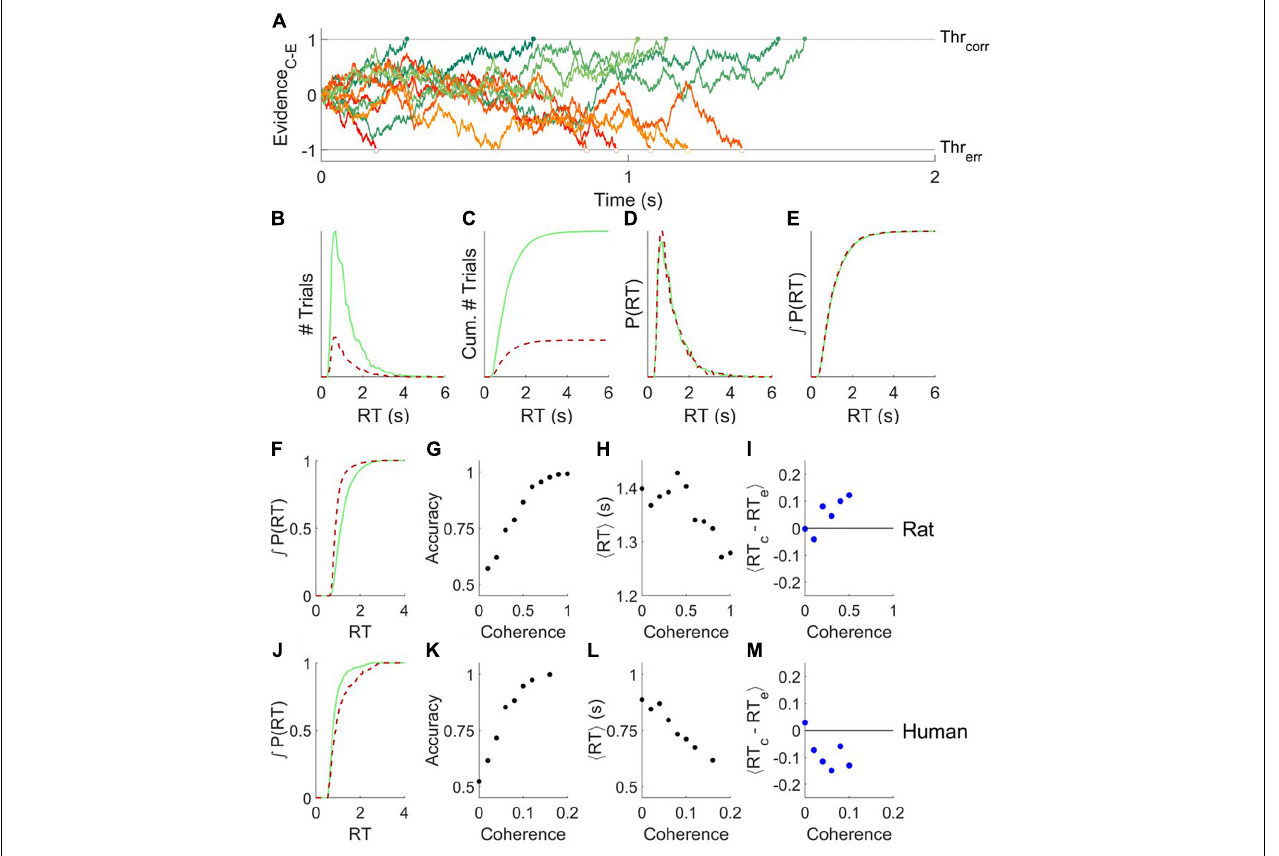
FIGURE 1 | The basic drift diffusion model is incompatible with data from rats or humans. (A) Simulated evidence accumulation in a basic drift diffusion model, for six example trials that terminated in correct decisions (green shades, solid symbols) and six that terminated in error decisions (red shades, open symbols). Although an equal number of traces are shown, in the condition illustrated 80% of the traces terminated by crossing the correct boundary. (B) Response time distributions for errors (red, dashed) vs. correct trials (green, solid) of 10 4 trials like those simulated as in (A) . (C) Cumulatives of the distributions shown in (B) . (D,E) Distributions in (B,C) normalized to the number of trials. (F) Cumulative probability distribution of response time for errors and correct trials for an example experiment in a rat, a fixed-coherence experiment with 65% coherence, for which the rat was 82% correct. The null hypothesis that the distributions are the same can be rejected with P = 2.91e-171 ( N = 8851,1913) by two-tailed Kolmogorov–Smirnov (KS) test. (G–I) . Analysis of an example rat psychometric experiment. (G) Accuracy increased with coherence. (H) Mean response time decreased with coherence. (I) On average, the response time of a correct trial is greater than that of a temporally nearby error trial of the same coherence. (J) Like (F) , for an example experiment in a human, a fixed-coherence experiment with 10% coherence for which the subject was 83% correct; P = 4.69e-05 ( N = 745,153) by KS test. Errors are later than correct trials, unlike either the DDM model (E) or rats (F) . (K–M) Like (G–I) , for an example human psychometric experiment. (M) Error trials are longer than correct trials on average, unlike rats, and also incompatible with DDM. Data from Shevinsky and Reinagel (2019) and Reinagel and Shevinsky